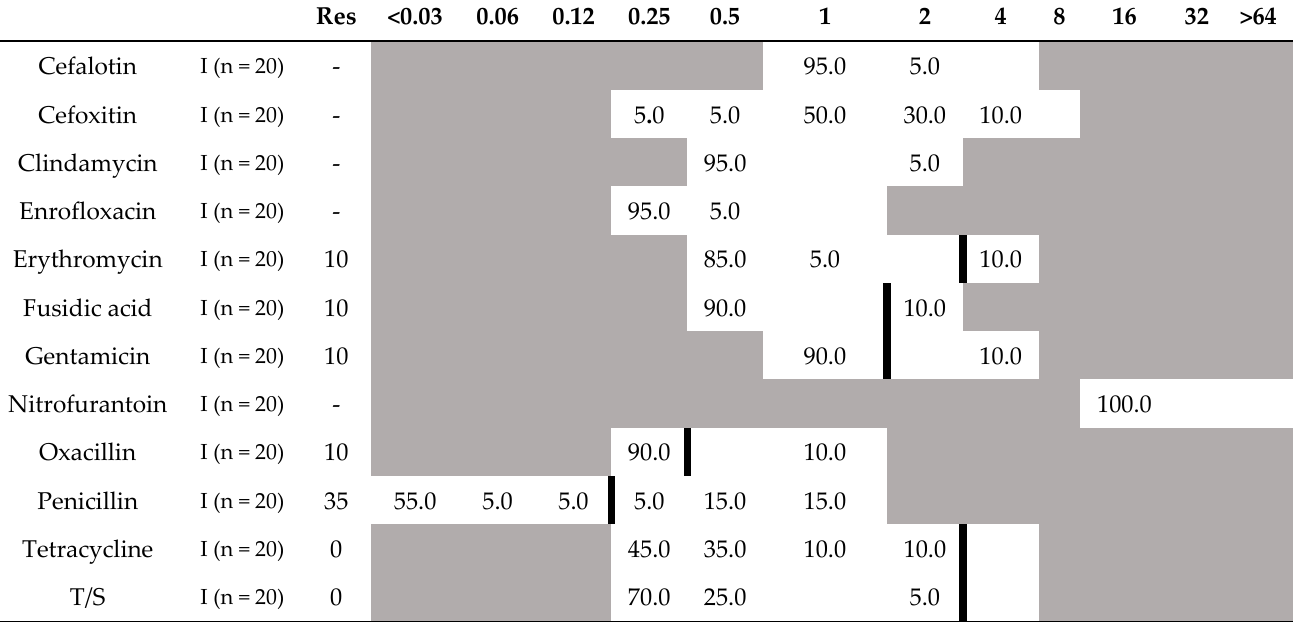
Table 4. Distribution of MICs (mg/L) and resistance of the 20 isolates of Staphylococcus spp. from the cranial vagina of inseminated mares (I). The results are shown as the percentage of isolates